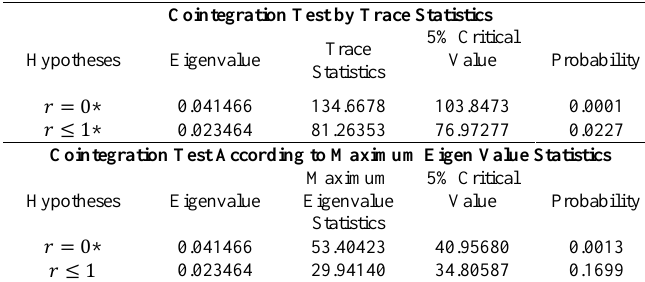
Table 5: Johansen Cointegration Test Results Cointegration Test by Trace